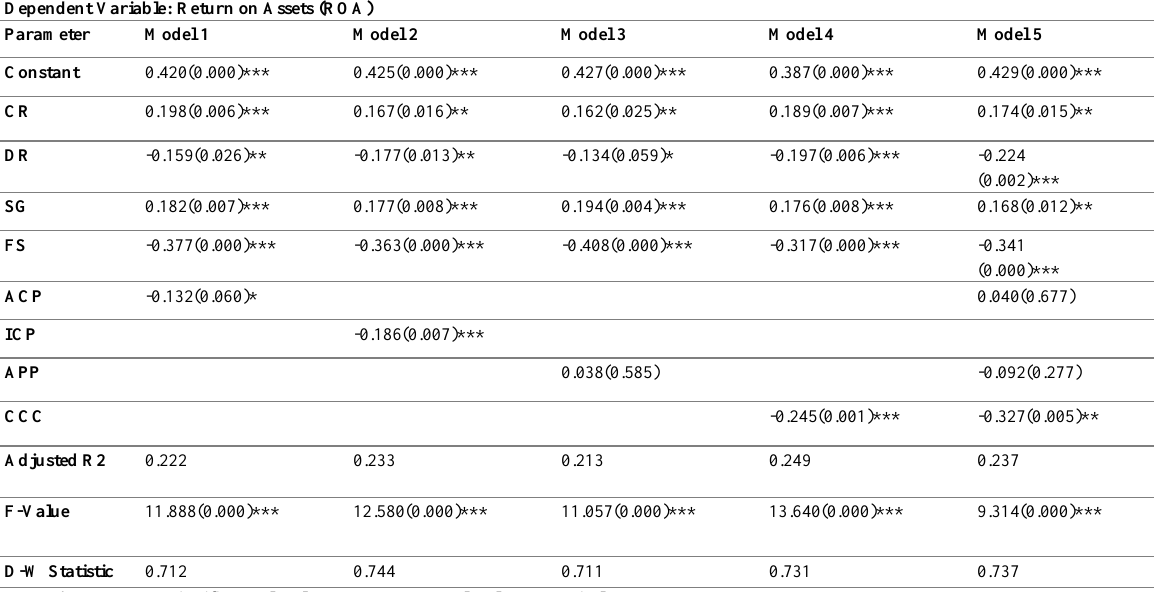
Table 4: Regression Result for Dependent Variable